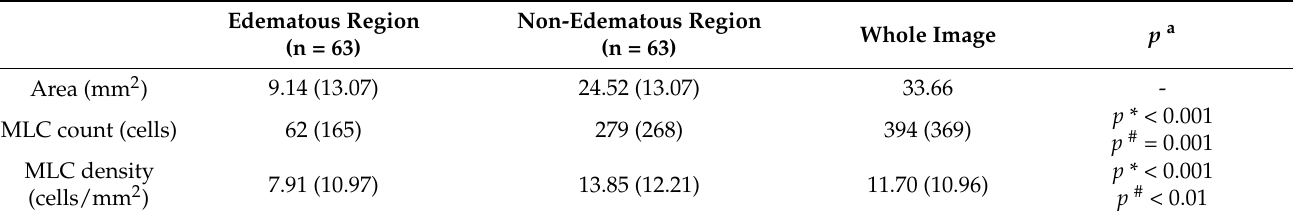
Table 3. Comparison of MLC parameters between retinal edema regions and non-edematous regions in RVO eyes.